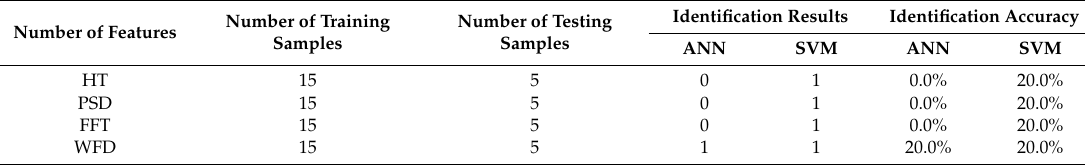
Table 5. Experimental results of damage identification based on single feature.